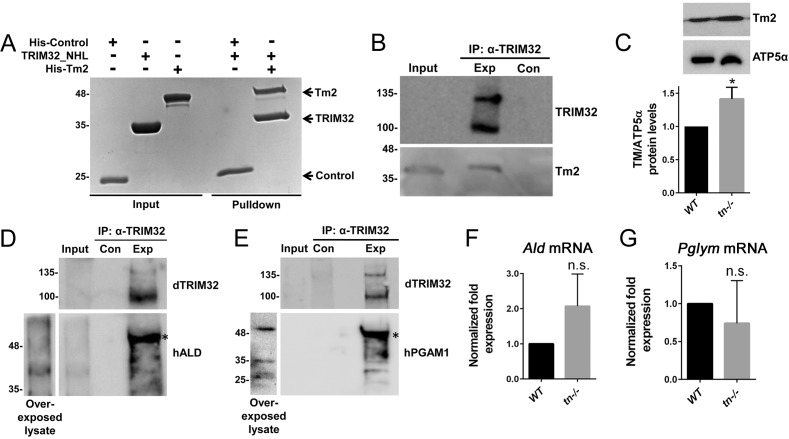
TRIM32 co-purifies with Tm2 and other proteins.(A) In vitro binding assay shows that His-tagged Tm2, but not the His-tagged SCIN control protein, directly binds untagged TRIM32_NHL. (B) Tm is found to co-immunoprecipitate with TRIM32 in L3 larval lysates. (C) Western blot depicting overall protein levels in WT or tn-/- whole larvae quantitated relative to ATP5α. Tm protein levels are increased in tn-/- mutants compared to WT controls. N = 3. (D,E) Immunoprecipitation of TRIM32 from L3 larval lysates co-purifies with Ald or Pglym. The glycolytic proteins are detected using antibodies against human ALD or PGAM1. Asterisk denotes the high molecular weight band that was also detected with Drosophila antibodies in Figure 2. (F,G) qPCR shows there is no decrease in the mRNA levels of Ald (F) or Pglym (G) in tn-/- at the L3 stage. mRNA was normalized to rp49 transcripts. N = 3 biological replicates and three technical replicates for each genotype. Mean +/- SD (*, p<0.05; n.s., not significant).